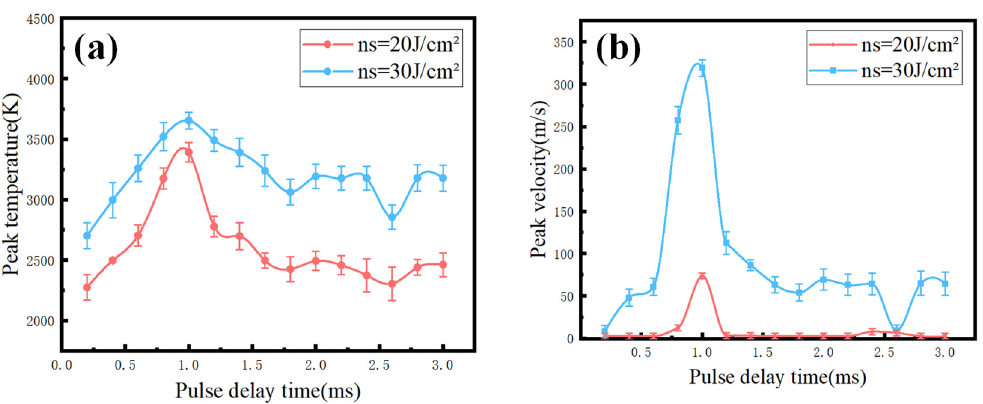
Figure 3. Variation in peak temperature and plasma peak velocity of fused quartz with pulse delay. ( a ) The variation in peak temperature pulse delay of fused quartz; ( b ) the variation in plasma peak velocity with pulse delay.